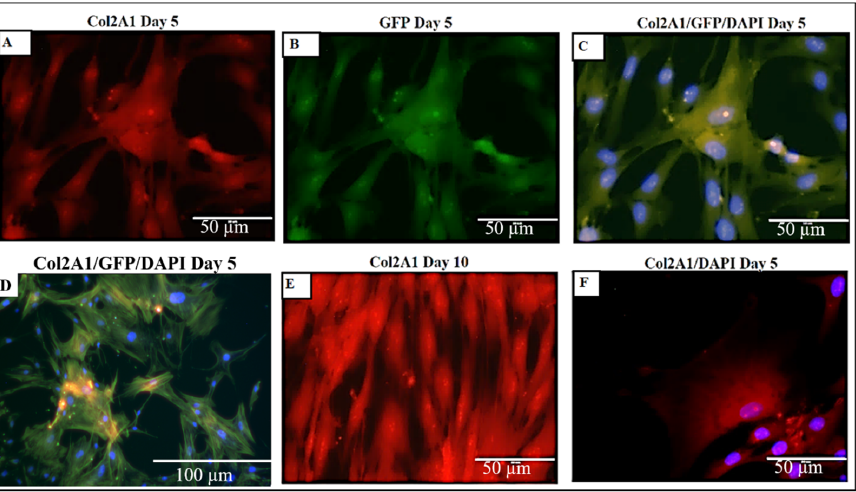
Figure 15. Progressive accumulation of Col2A1 in the cytoplasm of chondrocytes grown on DACS as culturing days increases. Col2A1 (Red) expressed on day 5 in cells seeded on DACS (probed with anti-Col2A1) ( A , E ). Cells on DACS stained with Phalloidin (as shown in green, B ). Phalloidin stained merged with Col2A1 and DAPI ( C ). ( D ) Cells on monolayer control probed for Col2A1 (red), stained with phalloidin (green), and DAPI (blue). ( F ) Col2A1 expressed in chondrocytes in control monolayer merged with DAPI day 5 of culturing. Scale bar, 50 µ m for A – F . Scale bar, 100 µ m for D